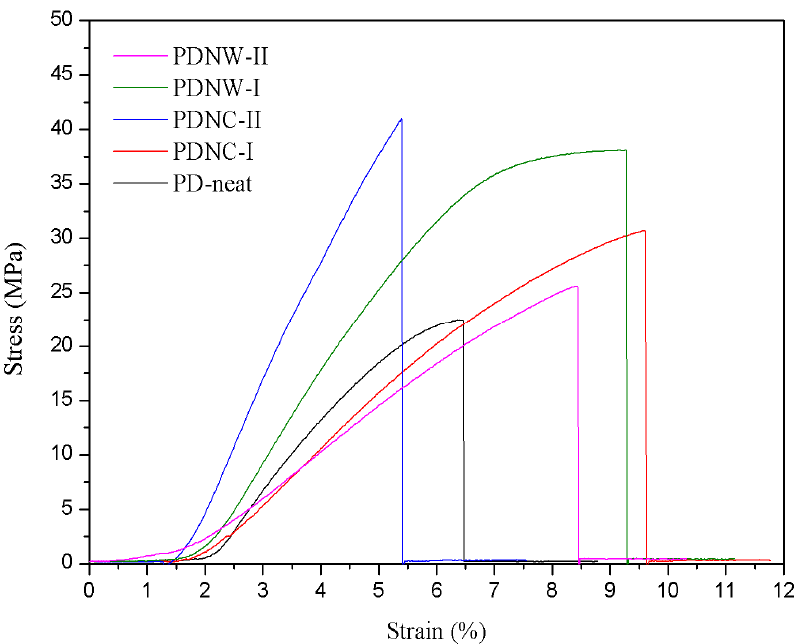
Figure 5. Mechanical stress-strain curves of PD-neat, PDNC-I, PDNC-II, PDNW-I and PDNW-II membranes.